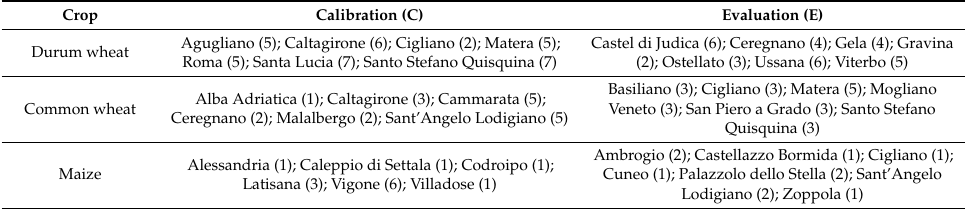
Table 4. Experimental sites and relative number of years (in brackets) for model calibration (C) and evaluation